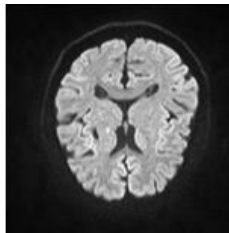
Figure 3. Example of data augmentation .